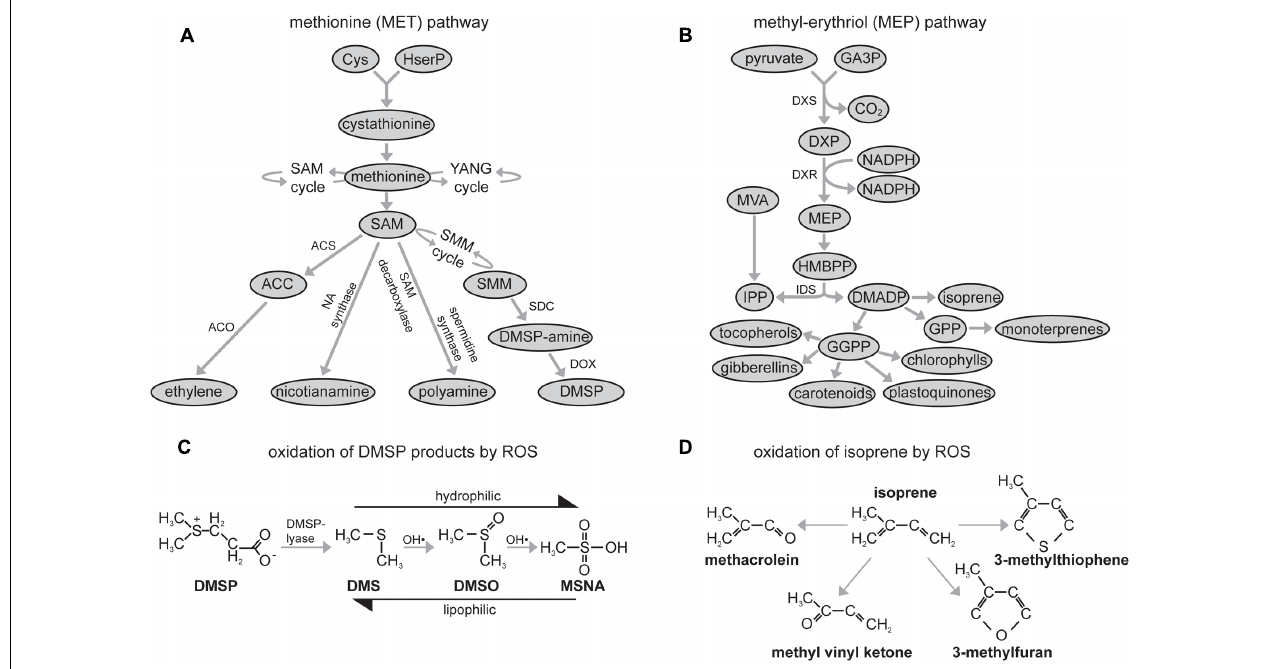
FIGURE 1 | Schematic diagrams of: (A) the methionine (MET) pathway (DMSP, dimethylsulphoniopropionate; SAM, S -adenosylmethionine; SMM, S -methylmethionine; NA, nicotianamine; PA, polyamine; ACS, Aminocyclopropane-1-carboxylic acid synthase (ACC synthase); ACO, ACC oxidase; SDC, SMM decarboxylase; DOX, DMSP-amine oxidase; HserP, O-phosphohomoserine), the stages involving synthesis of SMM and DMSP-amine occur outside the chloroplast envelope before DMSP-amine is transported into the chloroplast envelope where DMSP is formed (Amir et al., 2002); (B) oxidation of DMSP products by ROS (DMS, dimethylsulphide; DMSO, dimethylsuphoxide; MSNA, methane sulphinic acid) (Stefels, 2000; Sunda et al., 2002; Bentley and Chasteen, 2004); (C) the methyl-erythritol (MEP) pathway (GA3P, glyceraldehyde 3-phosphate; DMADP, dimethylallyl diphosphate; DXR, 1-deoxy- D -xylulose 5-phosphate reductoisomerase; GPP, geranyl diphosphate; GGPP, geranylgeranyl diphosphate; DXP, 1-deoxy- D -xylulose 5-phosphate; DXS, 1-deoxyxylulose 5-phosphate synthase; HMBPP, ( E )-4-hydroxy-3-methylbutyl-2-enyl pyrophosphate; MVA, mevalonate synthesized via the mevalonate pathway contributing to IPP) (Lichtenthaler et al., 1997), all stages other than MVA and the formation of gibberellins occur within the chloroplast, and; (D) oxidation of isoprene by ROS (Jardine et al., 2012).